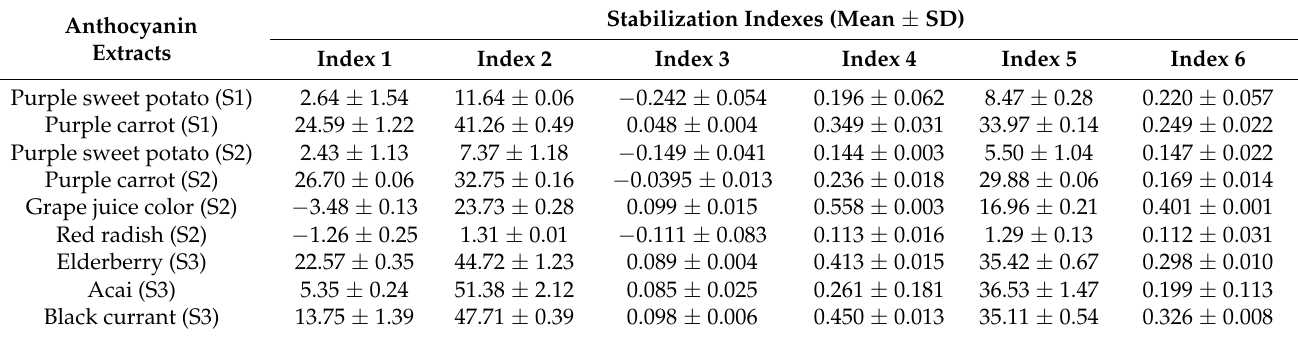
Table 2. Stabilization indexes of collected anthocyanin